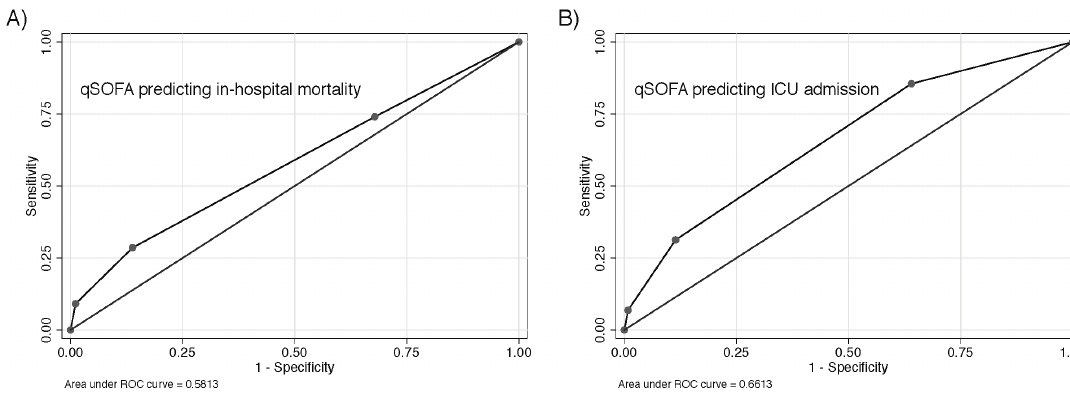
Fig 2. Receiveroperatingcharacteristic curve of qSOFA predicting A) in-hospitalmortality, B) ICU admission.